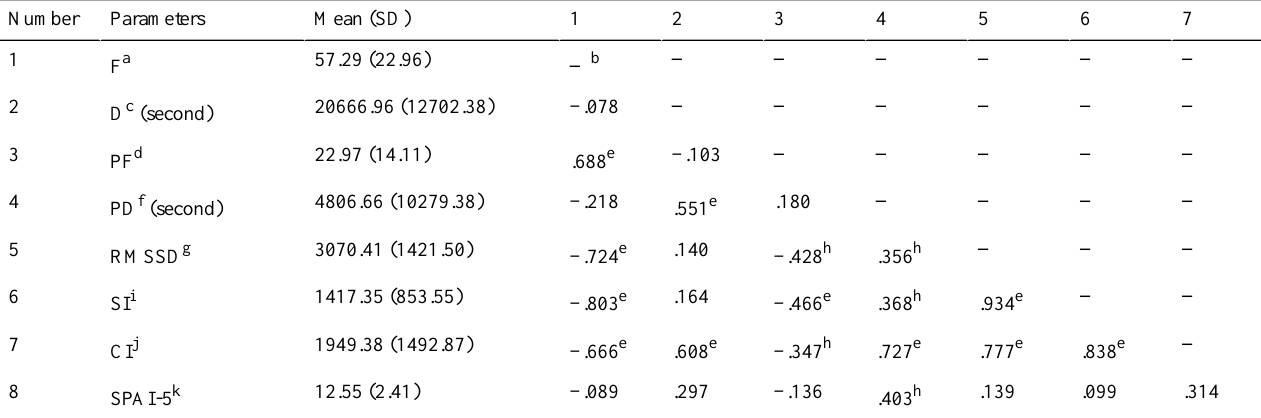
Table 1. Means, SDs, and correlations of app-generated parameters, and the total score of the 5-item Smartphone Addiction Inventory. 7654321Mean (SD)ParametersNumber